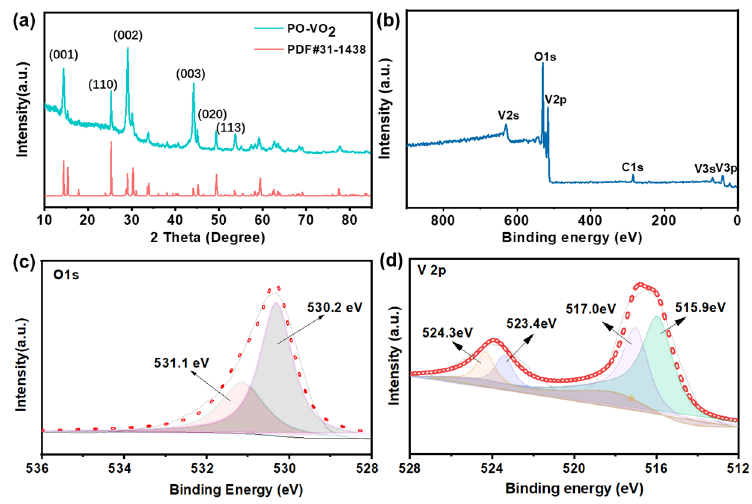
Figure 2. ( a ) The XRD pattern of the PO-VO 2 nanosheet; ( b ) the XPS survey spectrum; ( c ) the O 1s and ( d ) V 2p spectrum of the PO-VO 2 nanosheet.